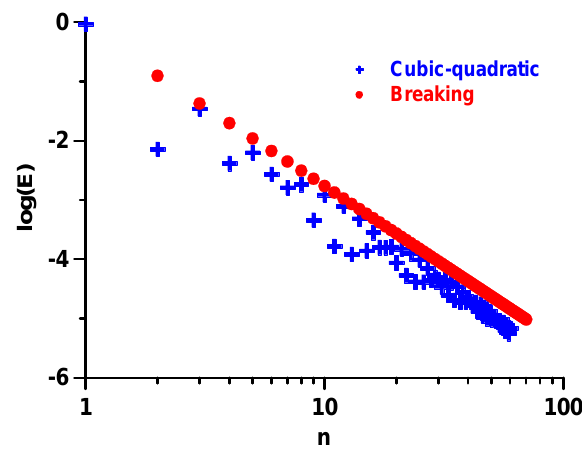
Figure 11. Spectrum of breaking Riemann wave for a case of CQ = 5 Fig. 11. Spectrum of a breaking Riemann wave for a case of CQ = Notice that there must be a limit to this effect, because, if CQ goes to infinity, the nonlinearity becomes purely cubic and the spectrum tends to the uniform breaking asymptotic shown in Fig. 7b.